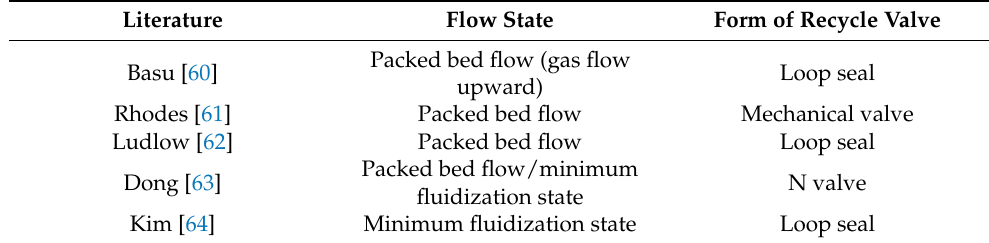
Table 2. Flow state of standpipe defined in literatures’